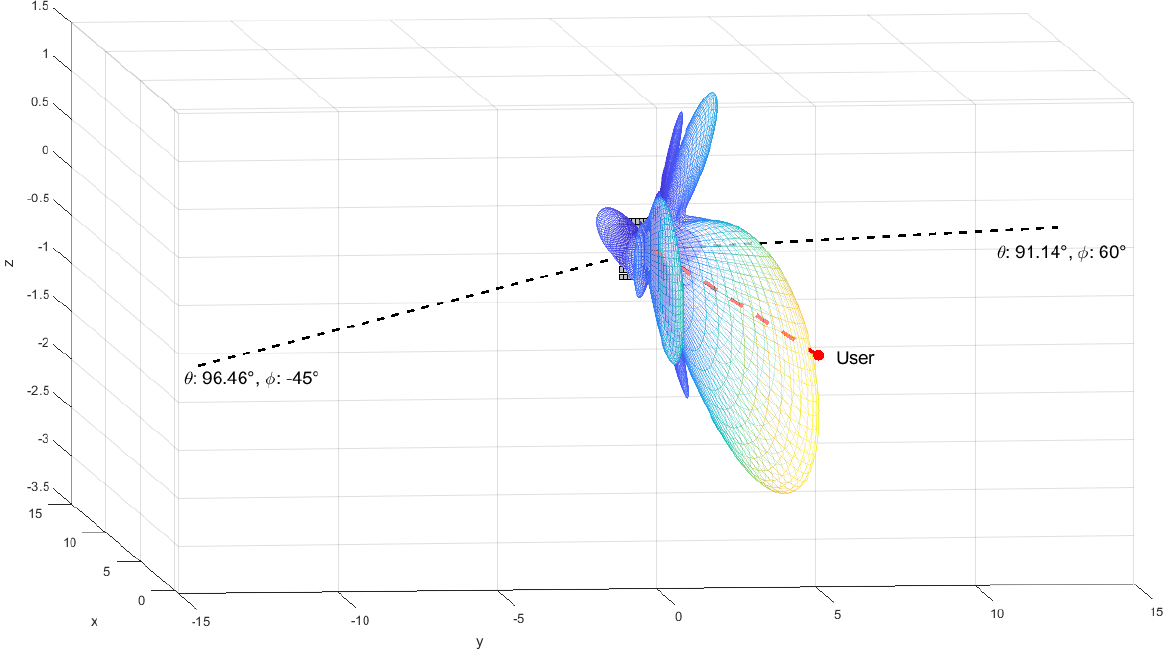
Figure 8. UPA radiation pattern with SLNR precoder w k targeted for UT k ( θ LOS , ZOD = 96.46 ◦ , φ LOS , AOD = 30 ◦ ) with two interfering users, N ty = 16, N tz = 8, N r = 1 for all